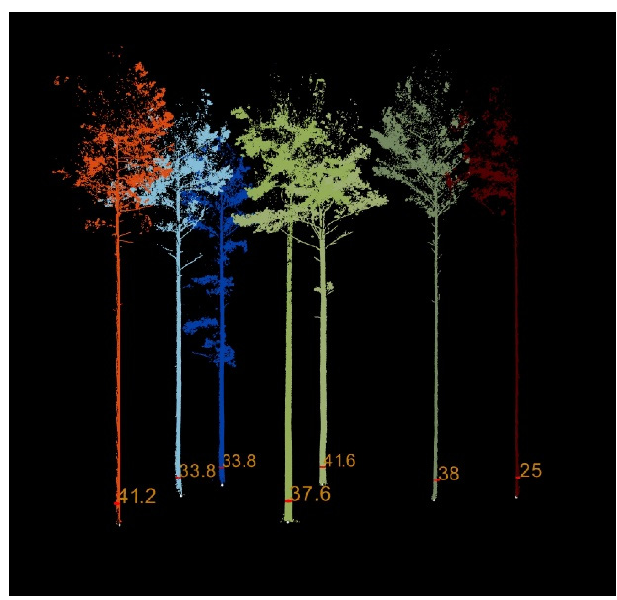
Figure 15. Measurement of DBH from TLS data in the 3D Forest software.